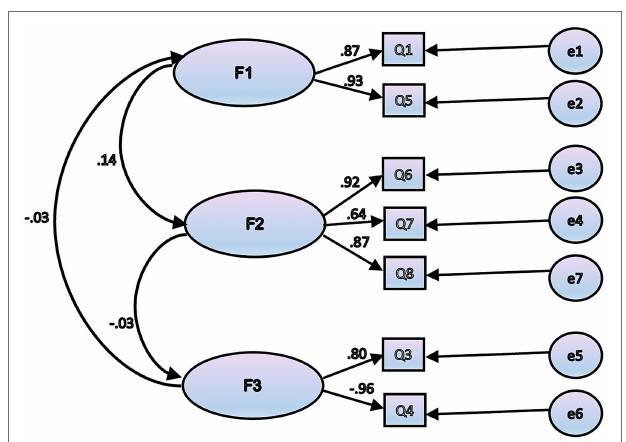
FIGURE 1 | Confirmatory factor analysis